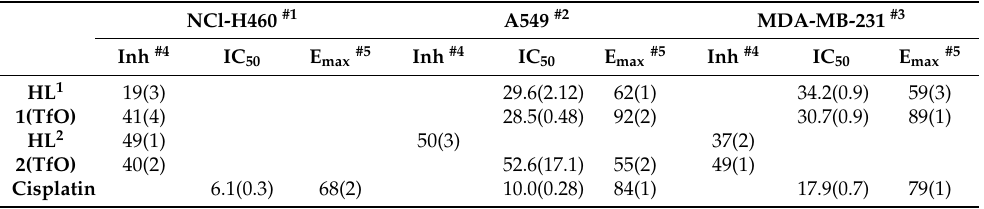
Table 4. Summary of the results of the cytotoxicity screening of the